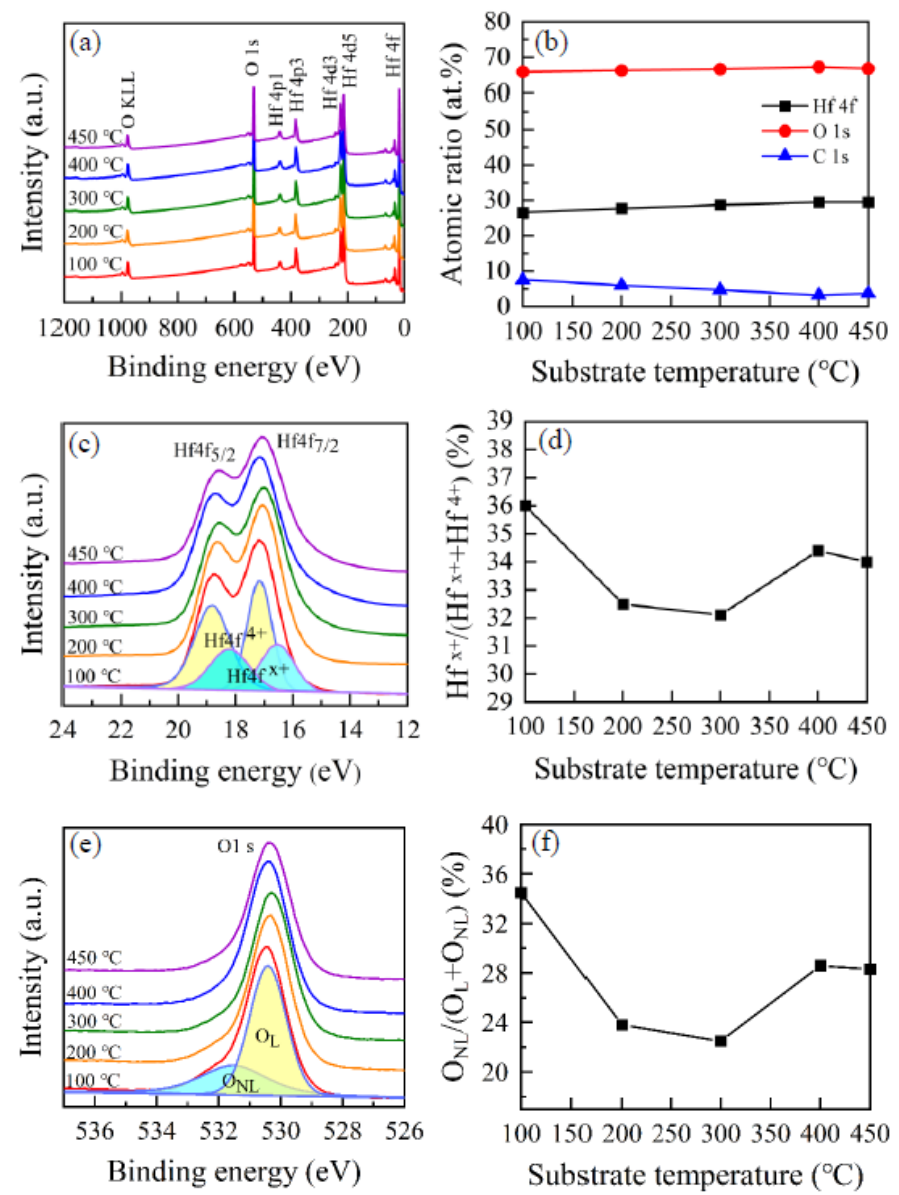
Figure 4. ( a ) XPS spectra of HfO 2 films with a binding energy between 1200 and 0 eV. ( b ) Content proportion of Hf, O and C in HfO 2 with different substrate temperatures. ( c ) High-resolution Hf 4f spectra of HfO 2 films with various substrate temperatures. ( d ) The area ratio of Hf x+ /(Hf x+ + Hf 4+ ) as a function of substrate temperatures. ( e ) High-resolution O 1s spectra of HfO 2 films with various substrate temperatures. ( f ) The area ratio of O NL /(O NL + O L ) as a function of substrate temperature.